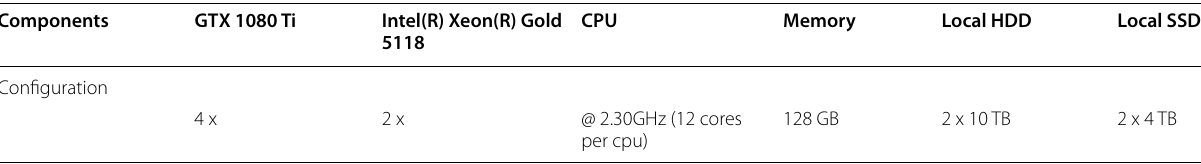
Table 2 Platform settings: The cluster, where we implement the experiments, consists of 18 nodes, each node’s configuration is shown in the table. The software environment includes: Anaconda, python-numpy, python-scipy, python-dev, python-pip, python- nose, g libopenblas-dev, git, Thensorflow, and python-matplotlib ++